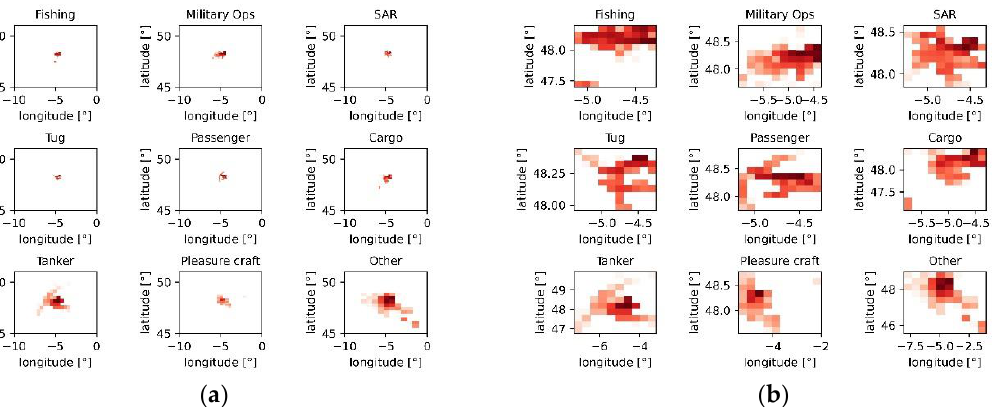
Figure 2. Thermal maps of active areas for different types of ships. ( a ) Thermal map over the entire area. ( b ) Thermal map shown in detail.